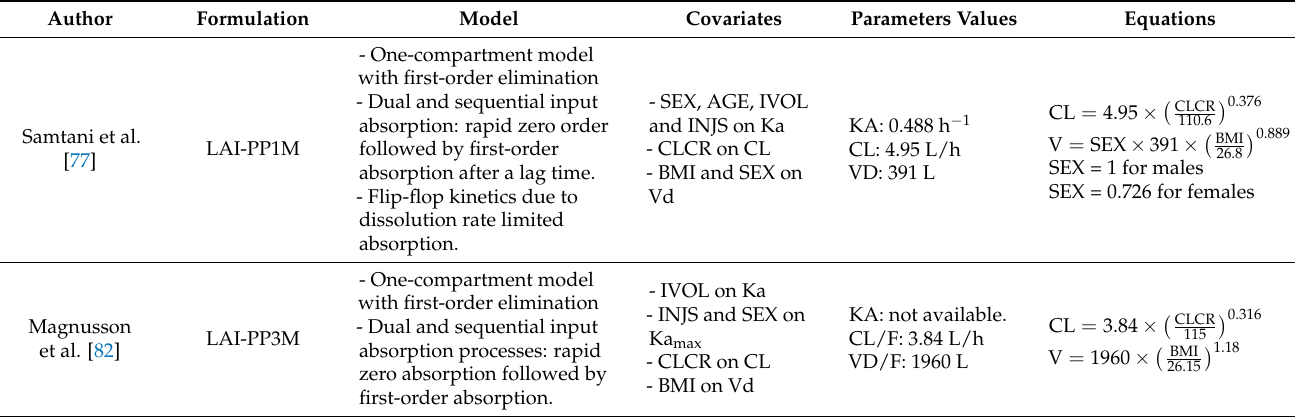
Table 3. Population pharmacokinetic models of paliperidone